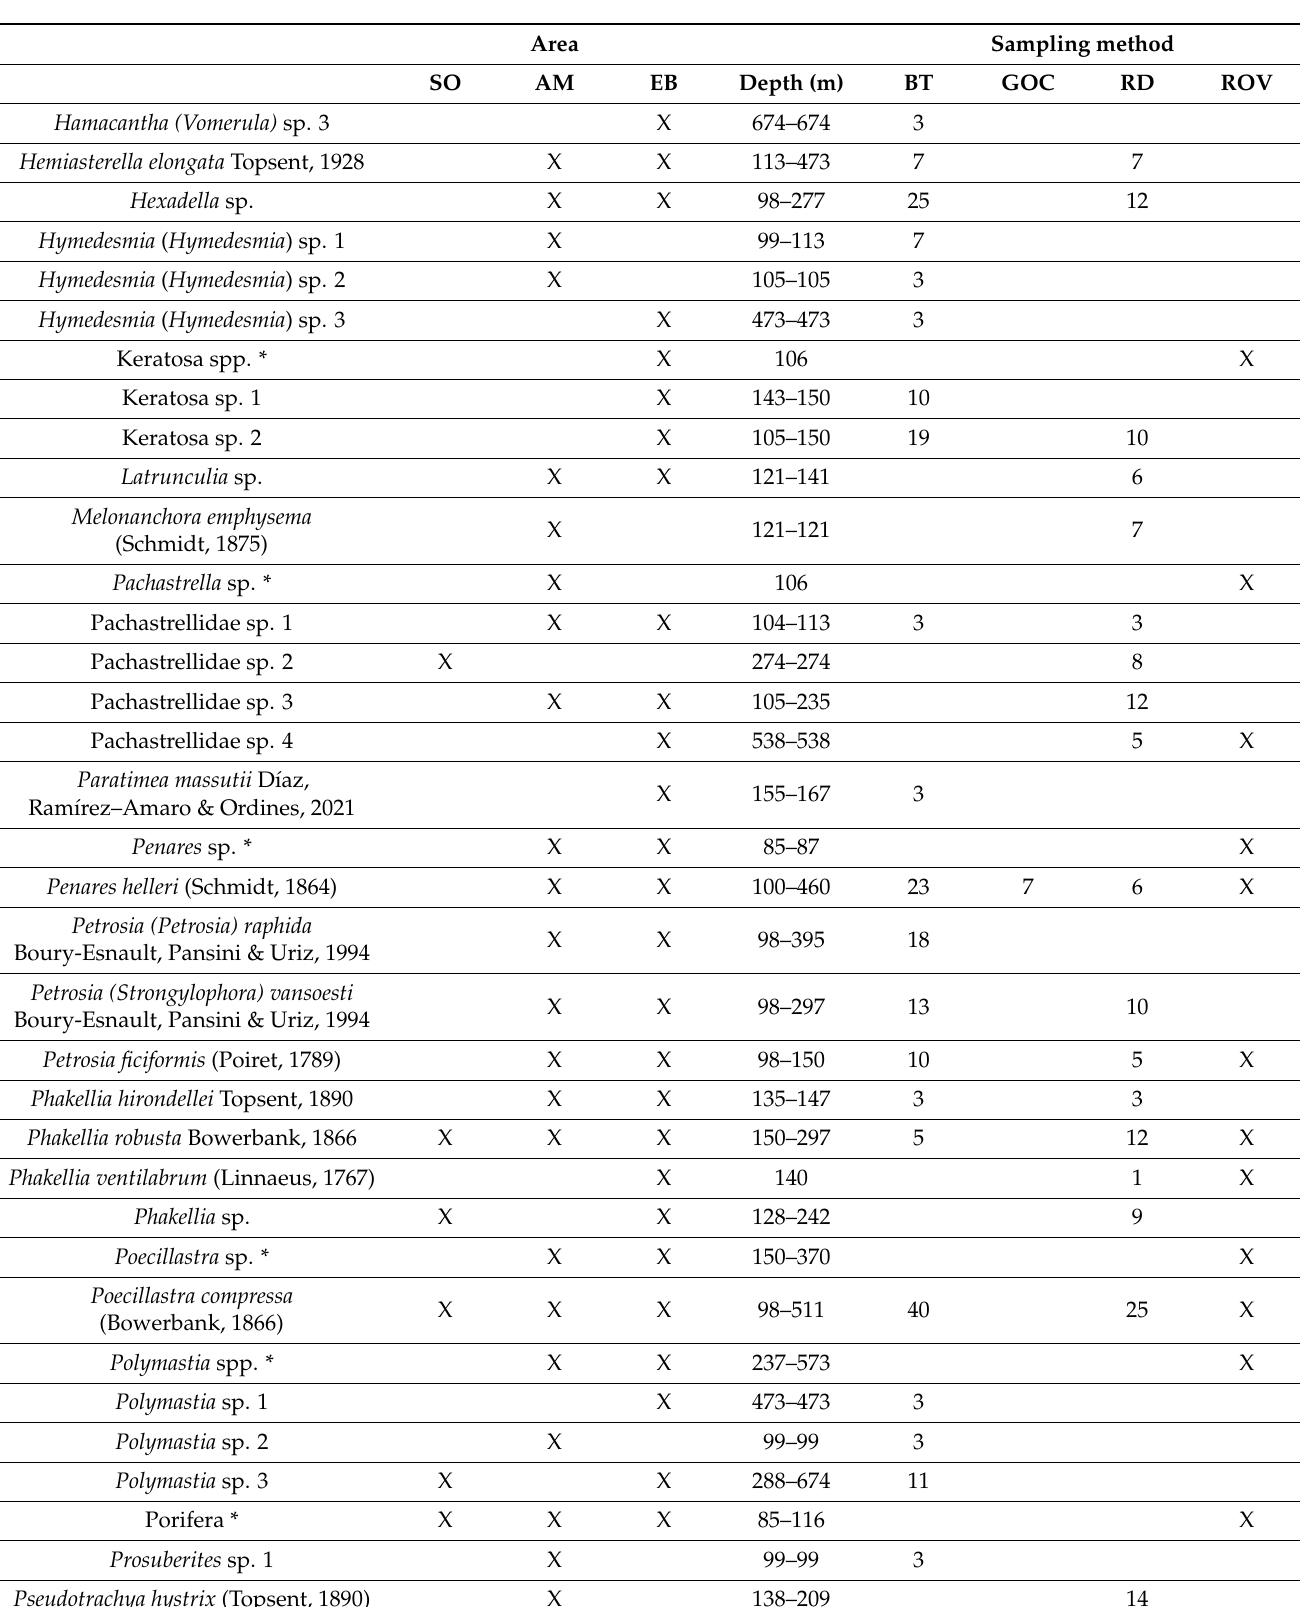
Table A7. Cont. Area Sampling